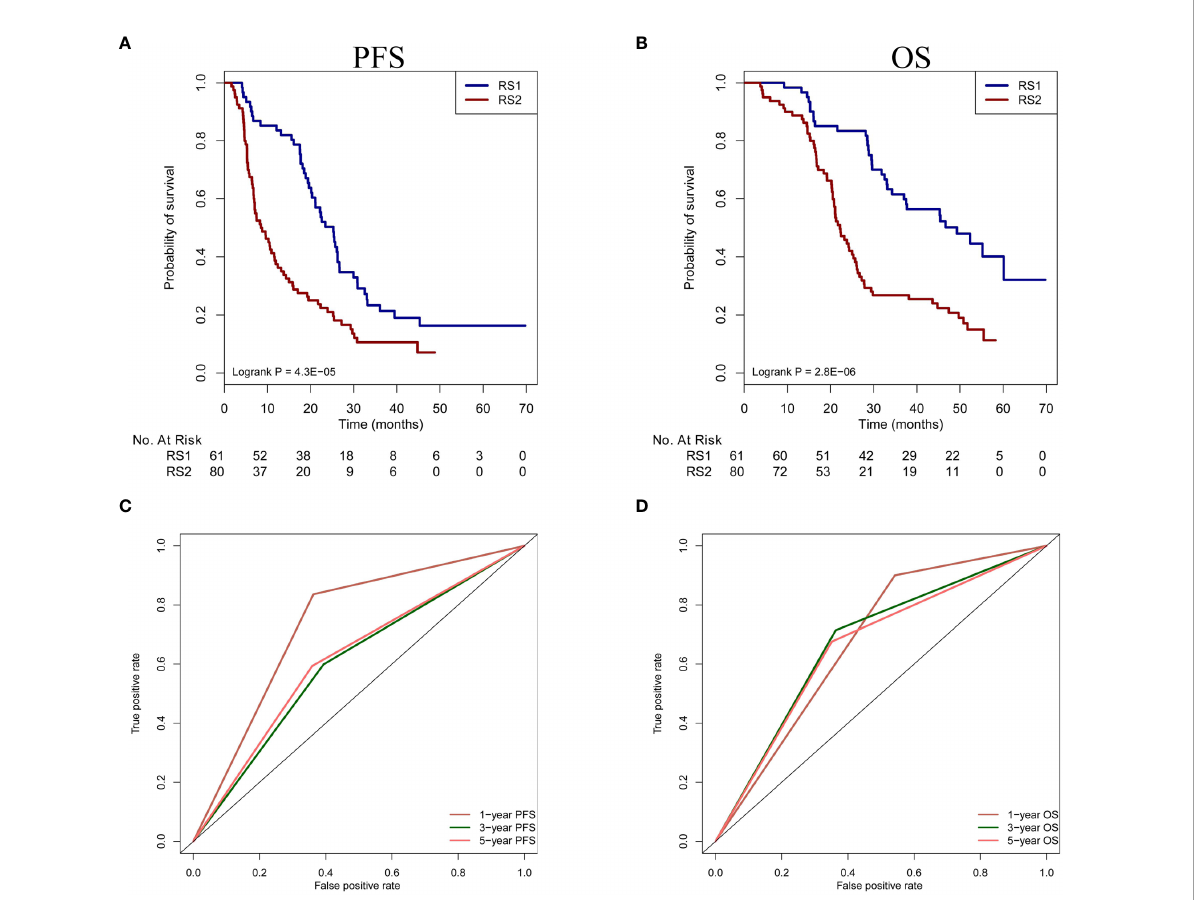
FIGURE 5 Prognosis prediction of PRS in patients undergoing TACE treatment. (A, B) The OS and PFS of two classi fi cation (RS1 vs. RS2) are compared in the patients. (C, D) Time-dependent ROC curve analysis is performed in 1-year-OS/PFS, 3-year-OS/PFS and 5-year-OS/PFS predictions. PFS, progression-free survival; OS, overall survival; PRS, pyradiomics score; TACE, transarterial chemoembolization; ROC, receiver operating